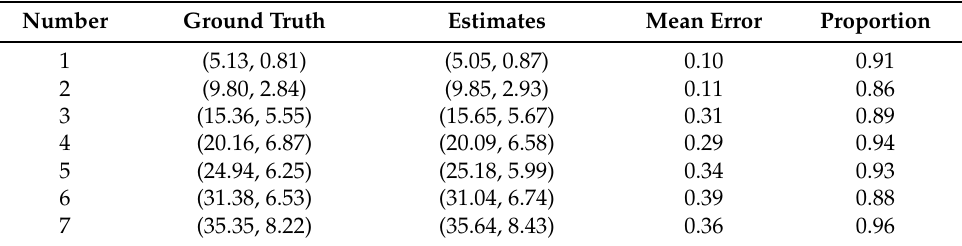
Table 4. Experiment Result of seven path points.